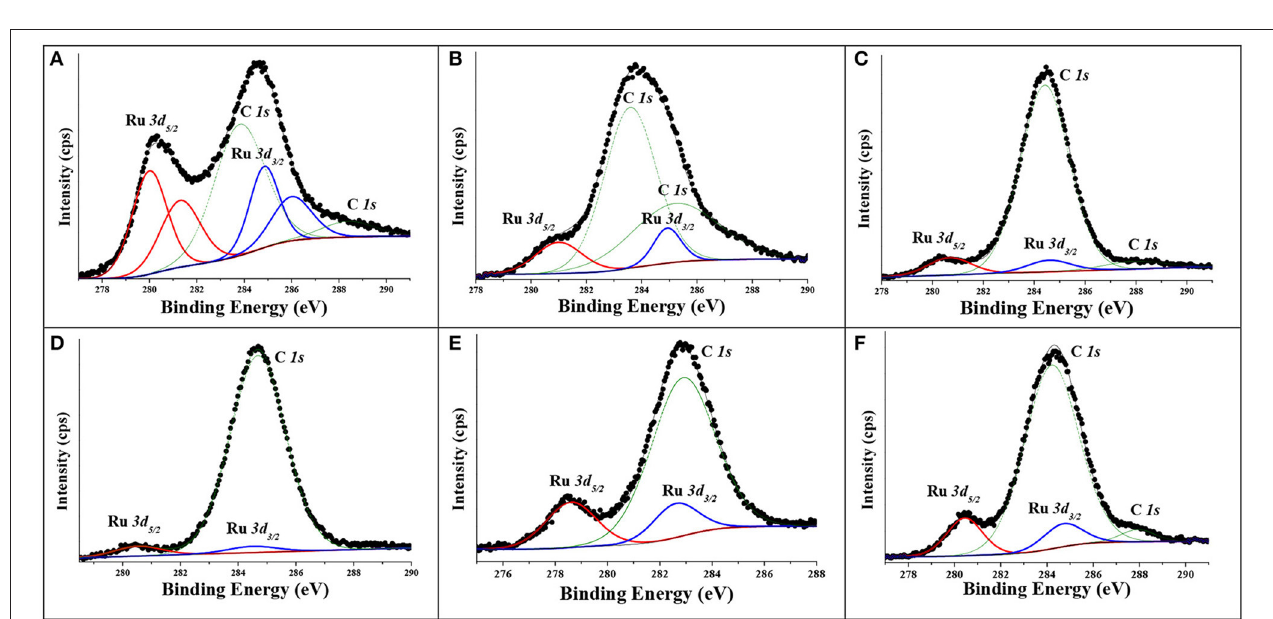
FIGURE 6 | X-ray photoelectron spectroscopy spectra of ruthenium on alumina: (A) C–Ru/Al, (B) Ru (1,5.0h) /Al, (C) Ru (1,5.1h) /Al, (D) Ru (1,5.4h) /Al, (E) Ru (0,9.4h) /Al, and (F) Ru (0,7.4h)